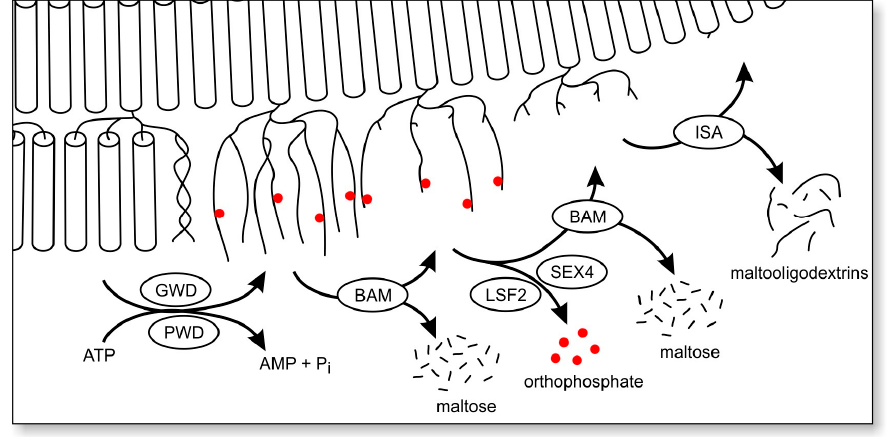
Figure 4. Role of phosphate esters during degradation of plant amylopectin. Degradation of starch granules in higher plants is facilitated by cycles of phosphorylation and dephosphorylation. Tightly packed, semi-crystalline exterior glucan chains of amylopectin undergo phase transition (specified in the text) through incorporation of phosphate esters by glucan water dikinase (GWD) and phosphoglucan water dikinase (PWD), both utilizing ATP. Exo-acting β -amylases (BAM) remove maltose units from the non-reducing ends, their action being obstructed by phosphate esters and branching points. The glucan phosphatases SEX4 (starch-excess 4) and LSF2 (Like-SEX4 2) remove phosphate esters and enable further BAM-mediated degradation. Isoamylase (ISA) is required for direct debranching in the amorphous layer of amylopectin before GWD-mediated phosphorylation initiates degradation of the subsequent semi-crystalline layer. Figure modified from [47,78].